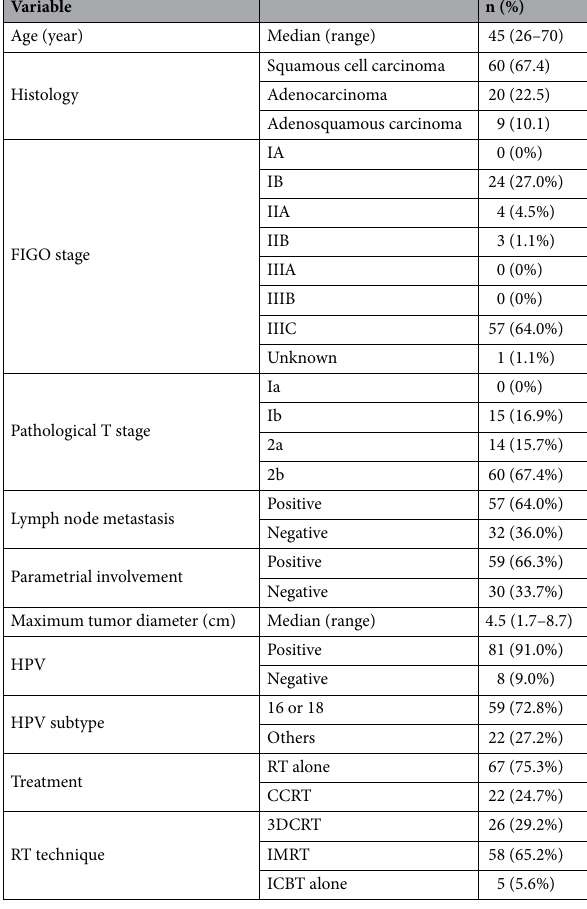
Table 1. Characteristics of 89 patients with cervical cancer. RT radiation therapy, CCRT concurrent chemoradiation therapy, 3D-CRT three-dimensional radiation therapy, IMRT intensity modulated radiation therapy, ICBT intracavitary brachytherapy, HPV human papillomavirus.